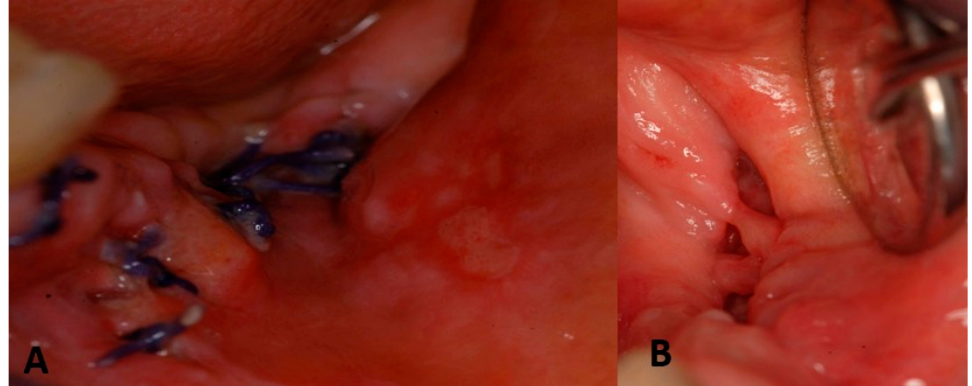
Figure 15. ( A ) Control of surgical site after 7 days; ( B ) Control of surgical site after 14 days (fully healed).